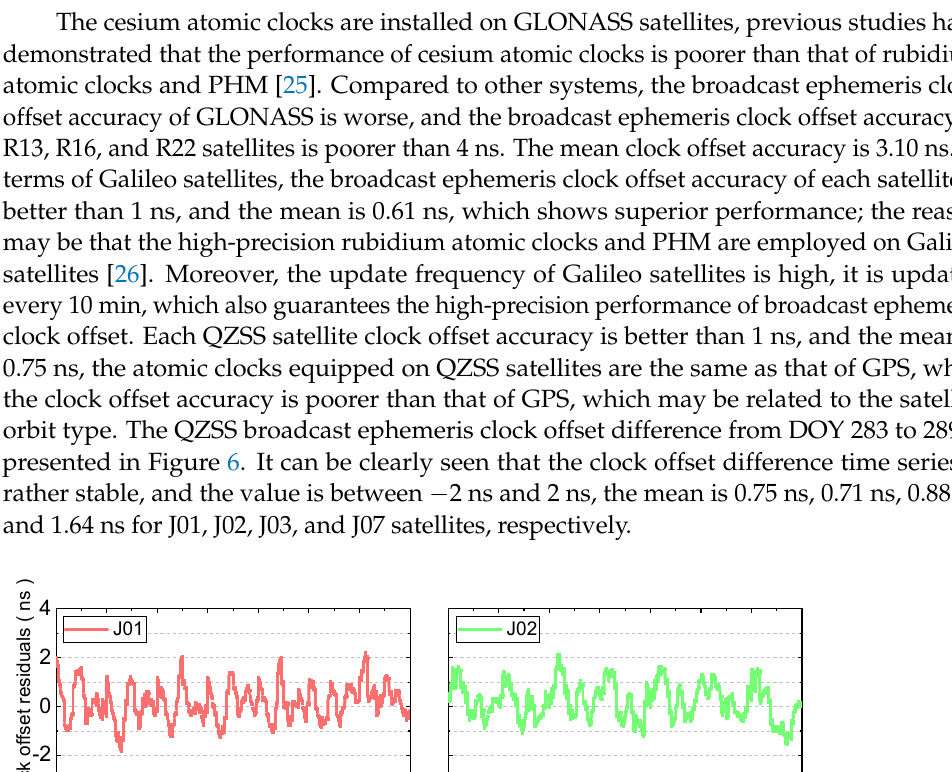
Figure 5. Clock offset accuracy of GPS/BDS-2/BDS-3/Galileo/GLONASS/QZSS satellites from broad- cast ephemeris. Figure 6. Clock offset difference time series of QZSS satellites from broadcast ephemeris. Table 3. Clock offset accuracy of each system (units: ns).